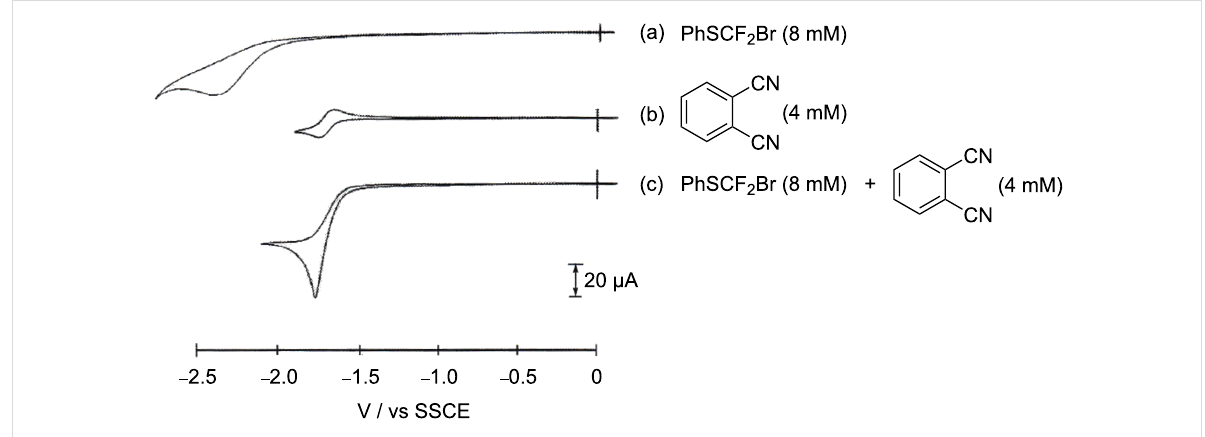
Figure 1: Cyclic voltammograms of (a) PhSCF 2 Br ( 1 , 8 mM) in 0.1 M n -Bu 4 NClO 4 /MeCN; (b) o -phthalonitrile (4 mM), and (c) o -phthalonitrile (4 mM) + 1 (8 mM). Scan rate: 100 mV/s.